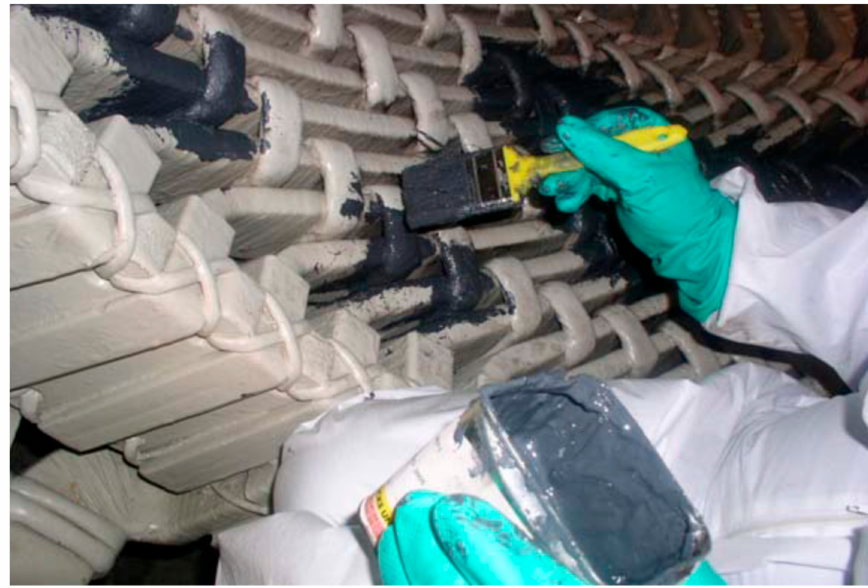
Figure 4. Painting of the restored area with